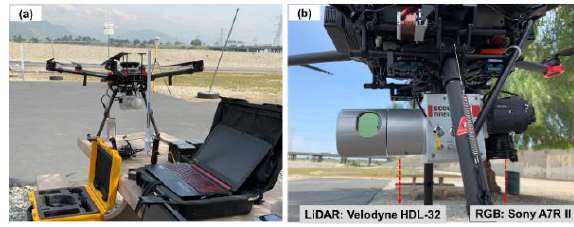
Figure 2. UAV platform and sensors. A DJI Matrice 600 Pro hexacopter integrated with a Phoenix Scout-32 system (a), the Phoenix Scout-32 system includes a Velodyne HDL-32 LiDAR sensor and a Sony A7RII RGB camera